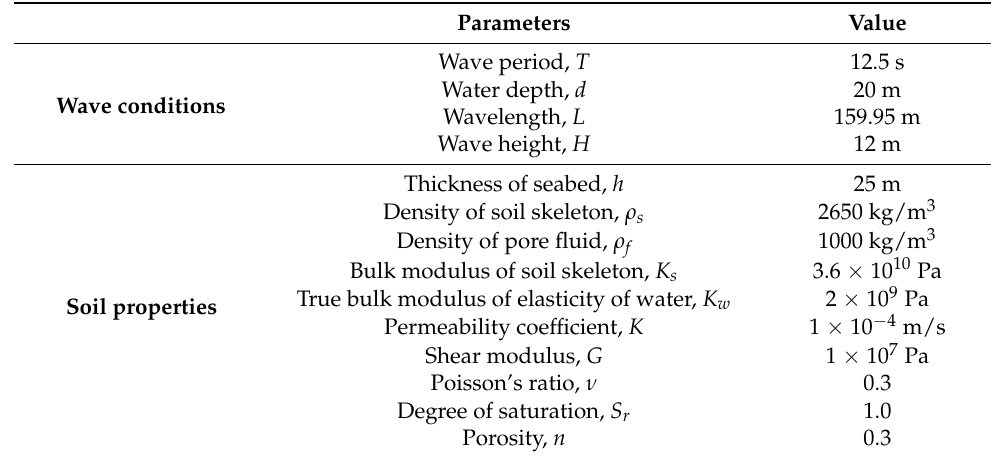
Table 1. Wave conditions and isotropic soil properties